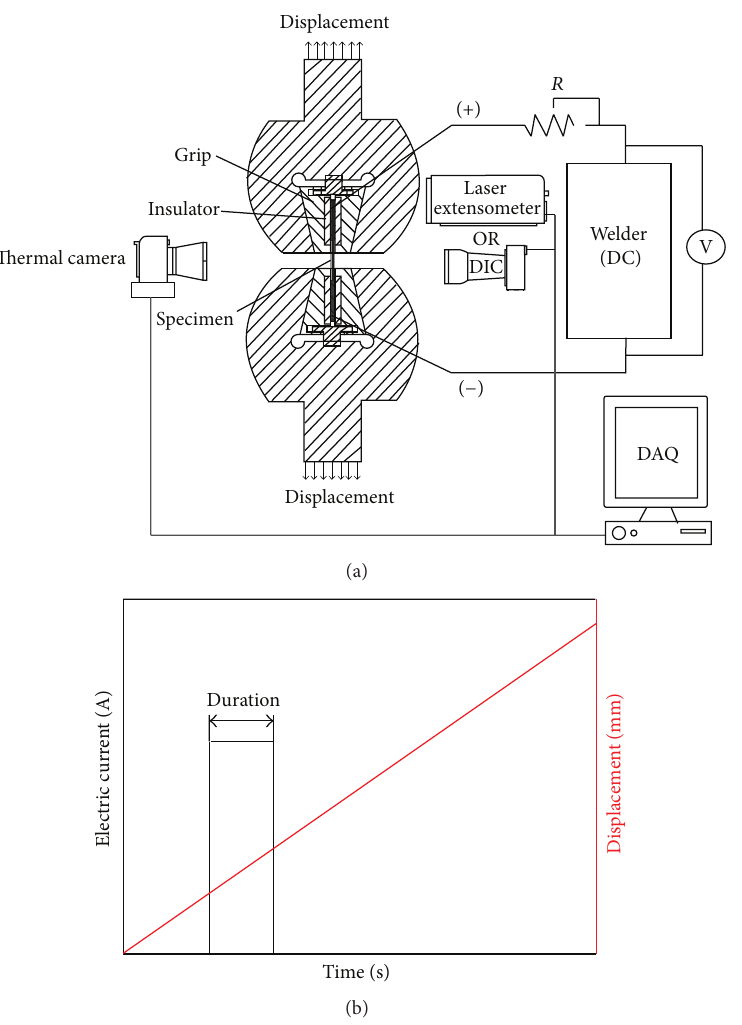
Figure 1: Schematics of (a) the experimental set-up and (b) applying a single pulse of electric current during deformation.